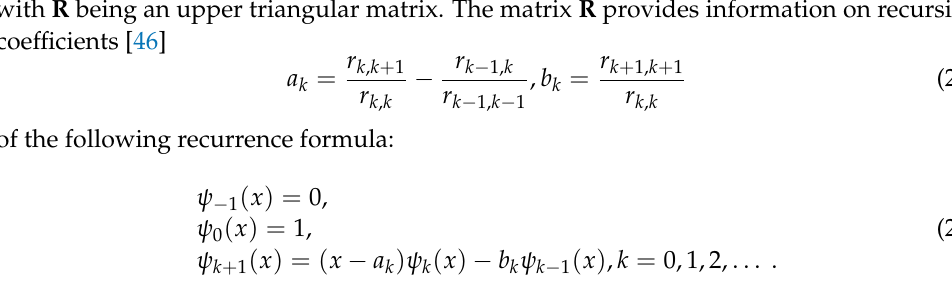
Figure 2. Framework of the SSR-ETM and ETM.